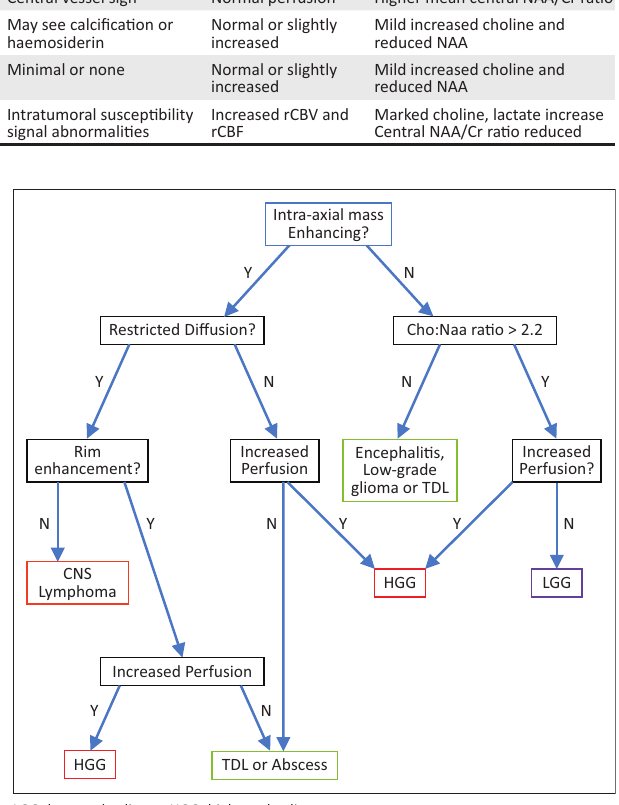
LGG, low-grade glioma; HGG, high-grade glioma FIGURE 8: Algorithm – Approach to intracranial